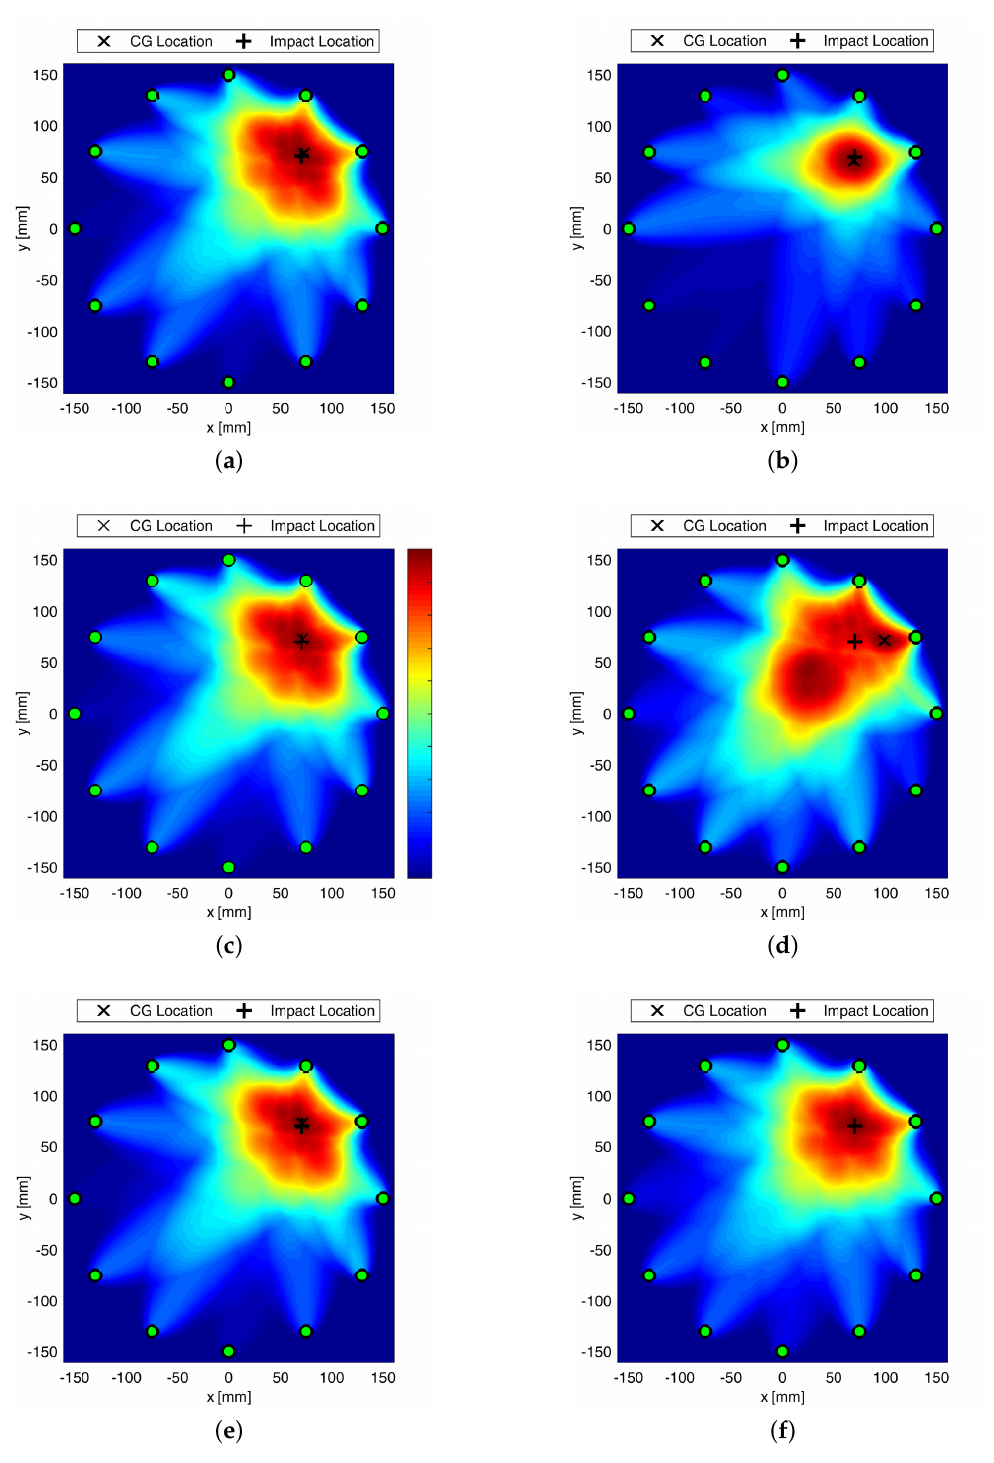
Figure 8. Maps of Damage Probability Index using elliptic weight distribution function relying on energy ( a ), correlation ( b ), RMSD ( c ), time of flight ( d ), signal amplitude ( e ), and fusion ( f ) based damage indicator. Colorbar in between 0 and 1. SHM carried out at 50